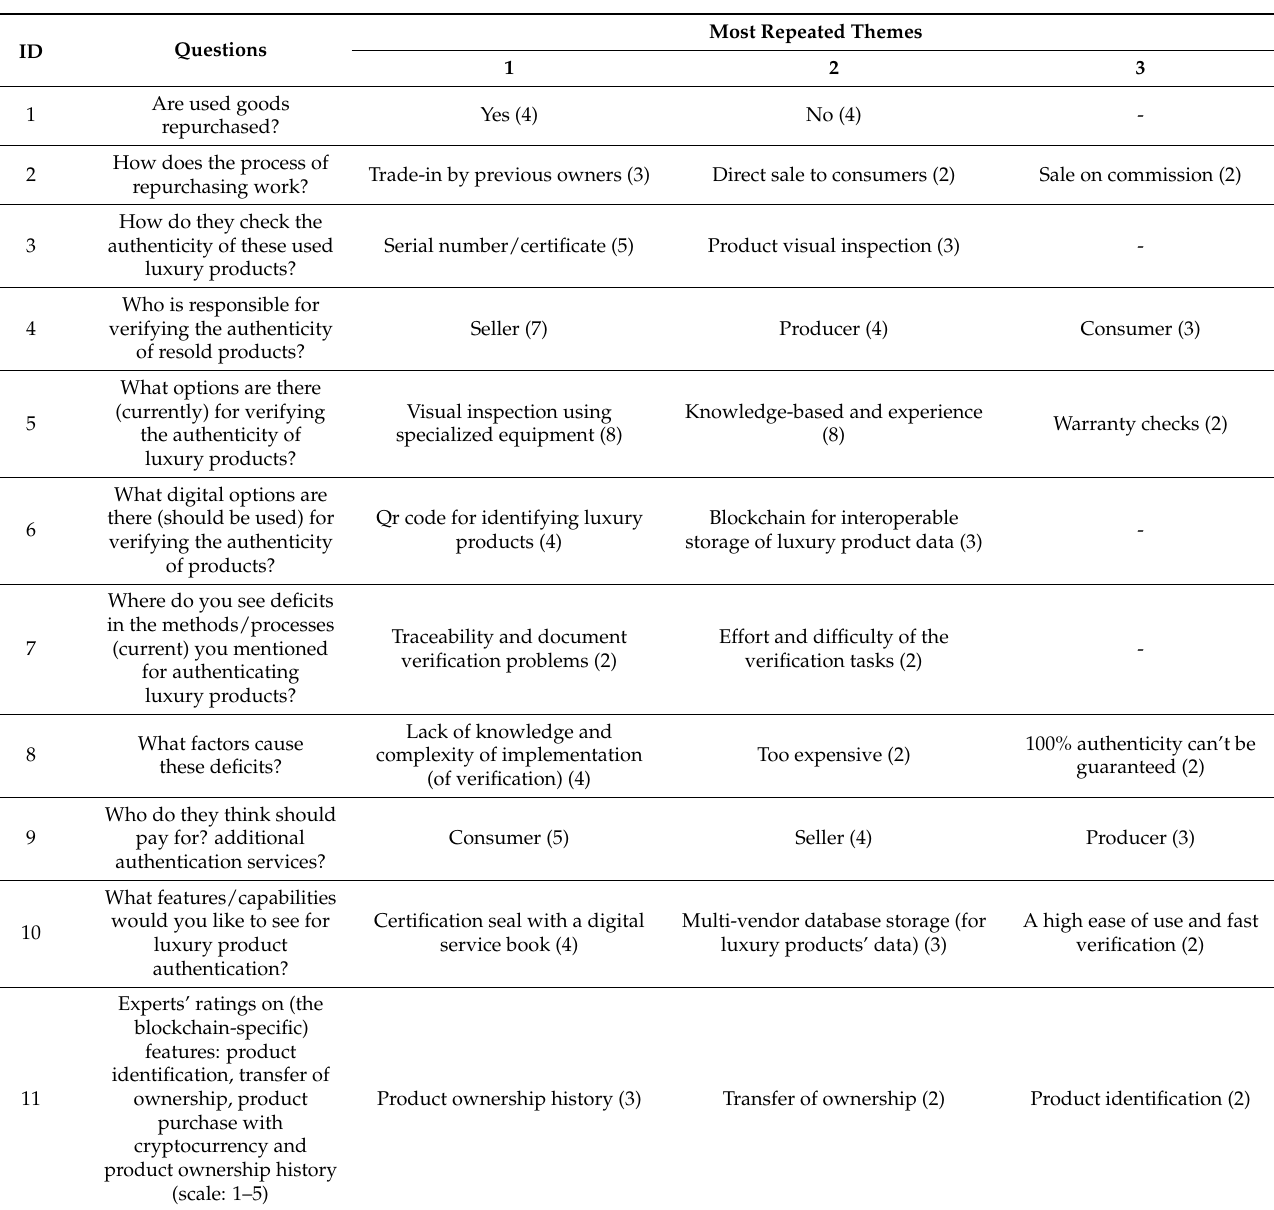
Table 1. Thematic analysis results from the expert interviews on luxury product authentication and problems, adapted from